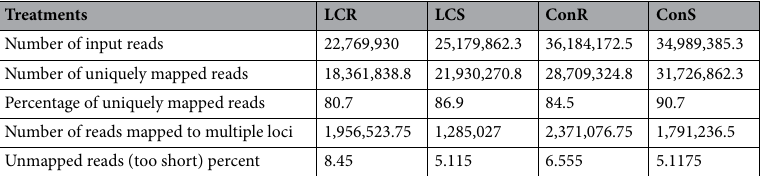
Table 1. RNA sequencing profile of tef samples under two different Ca 2+ levels in root and shoots. Samples were LCR (low calcium roots), LCS (low calcium shoots), ConR (control roots) and ConS (control shoots). Note that values are averages of reads from four biological